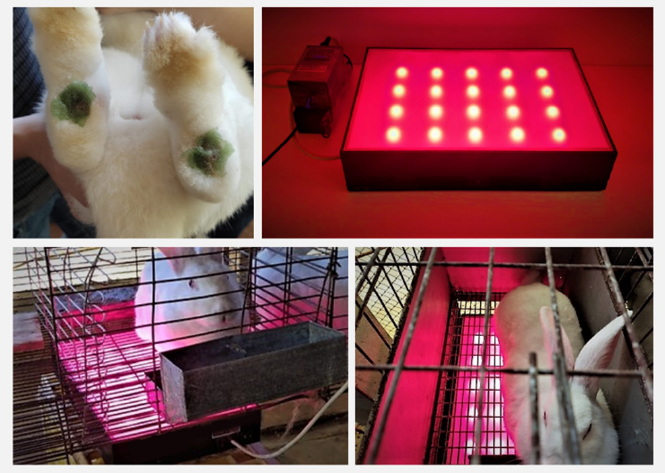
Figure 3. Gel administration and animal-illumination process.